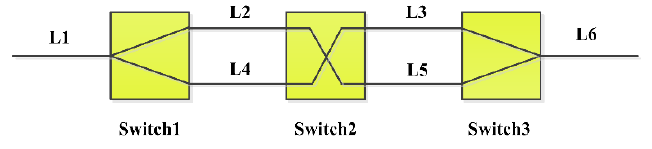
Figure 2. The setup of the programmable delay line.